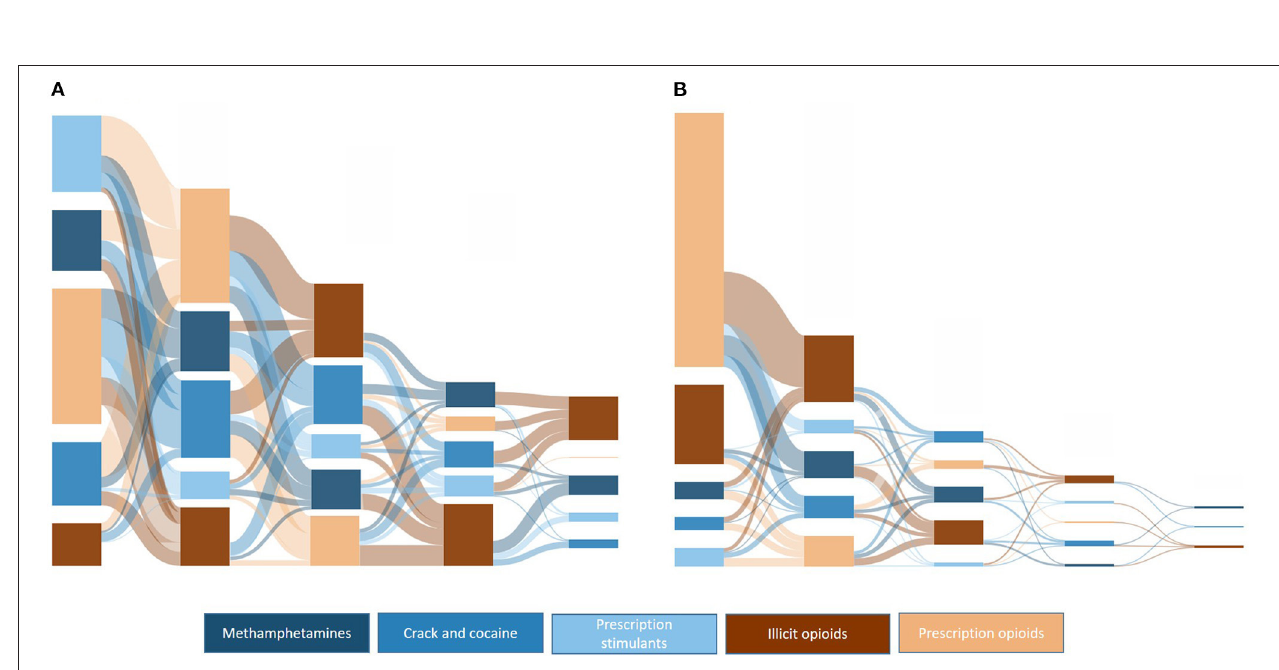
FIGURE 10 | Sankey plots of ordered drug transitions by decade of initial drug exposure: (A) 1991–2000, n = 1,079; (B) 2010–2020, n = 749.